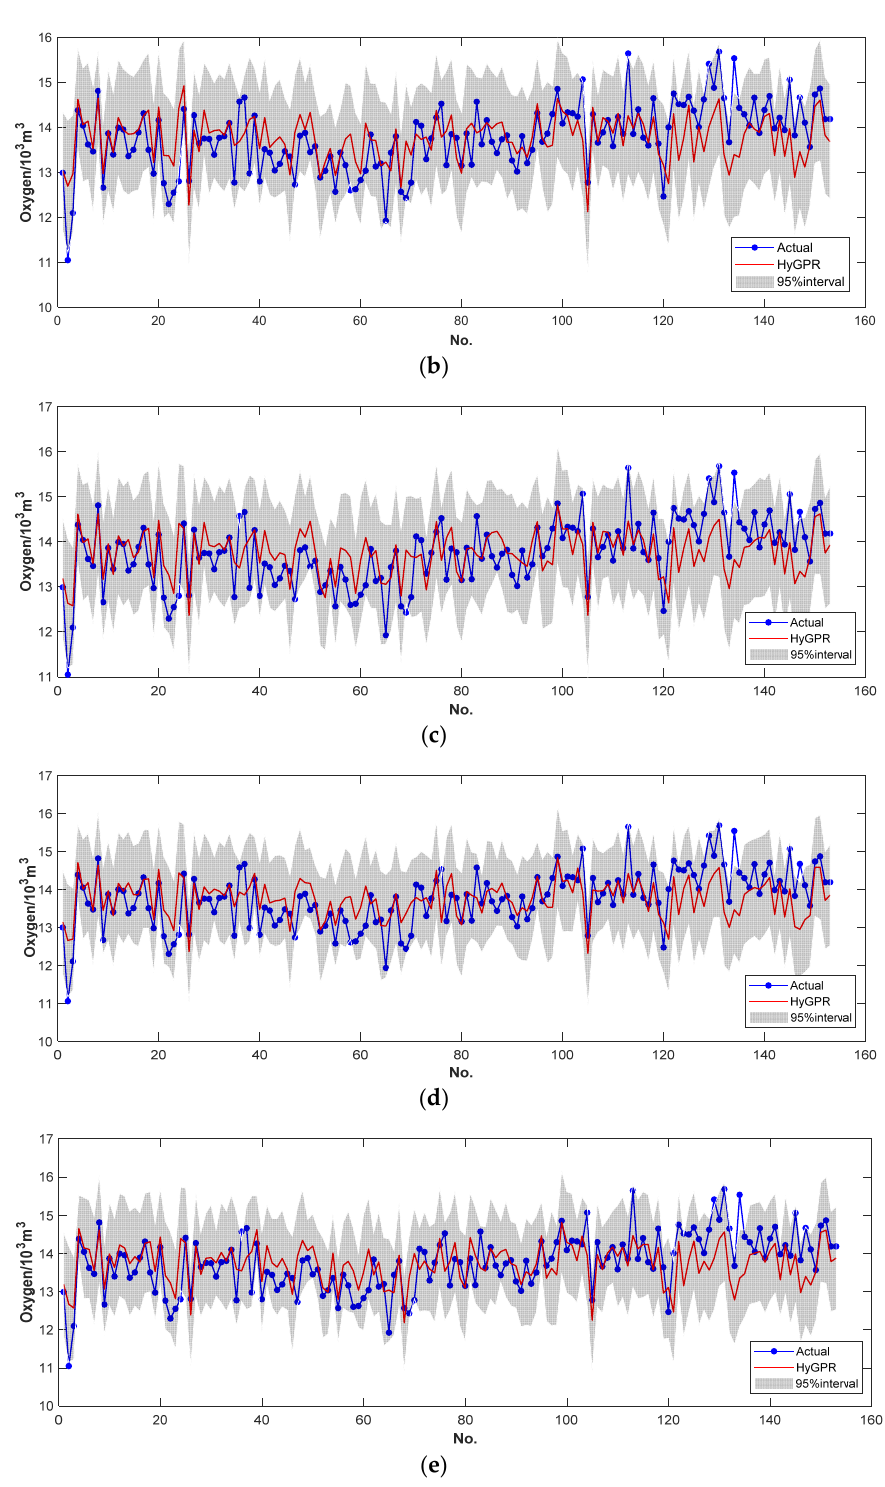
Figure 4. Forecasting results with candidate clusters: ( a ) Q = 1 ; ( b ) Q = 2 ; ( c ) Q = 3 ; ( d ) Q = 4 ; ( e ) Q = 5 .